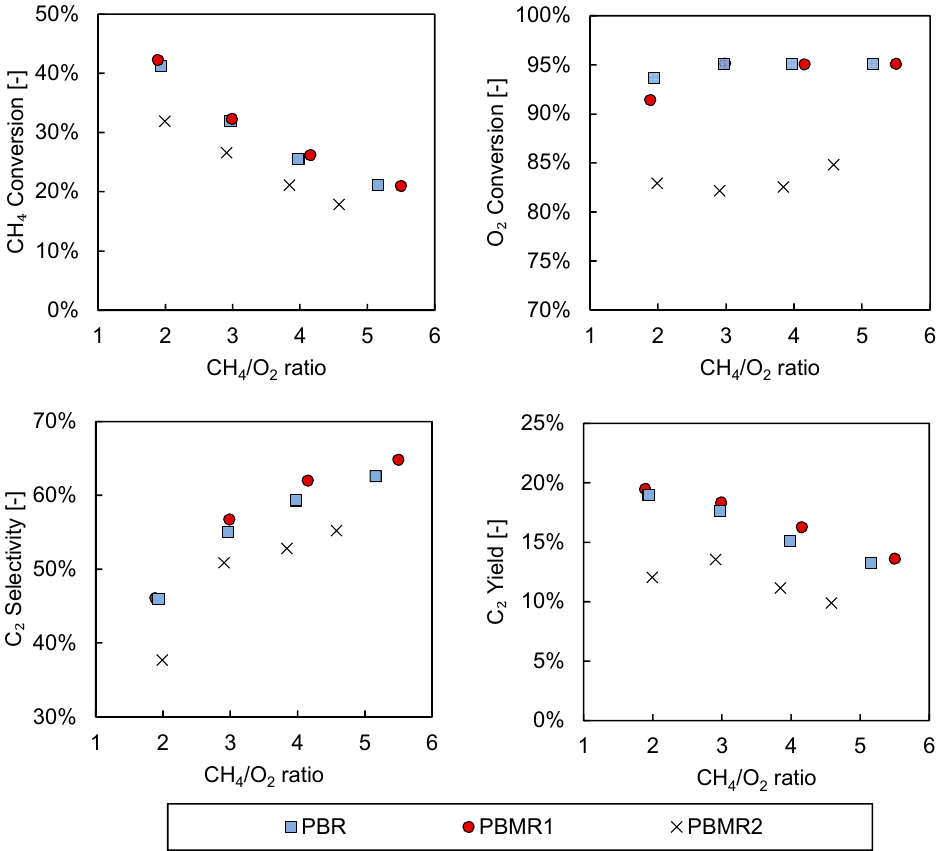
Figure 7. CH 4 conversion (top left), O 2 conversion (top right), C 2 selectivity (bottom left), and C 2 yield (bottom right) of the different reactor configurations (PBR, PBMR1, and PBMR2) employed for oxidative coupling of methane (OCM) in experiments carried out at 800 °C, 2 bar, and with a CH 4 inlet flow of 105 mL/min.